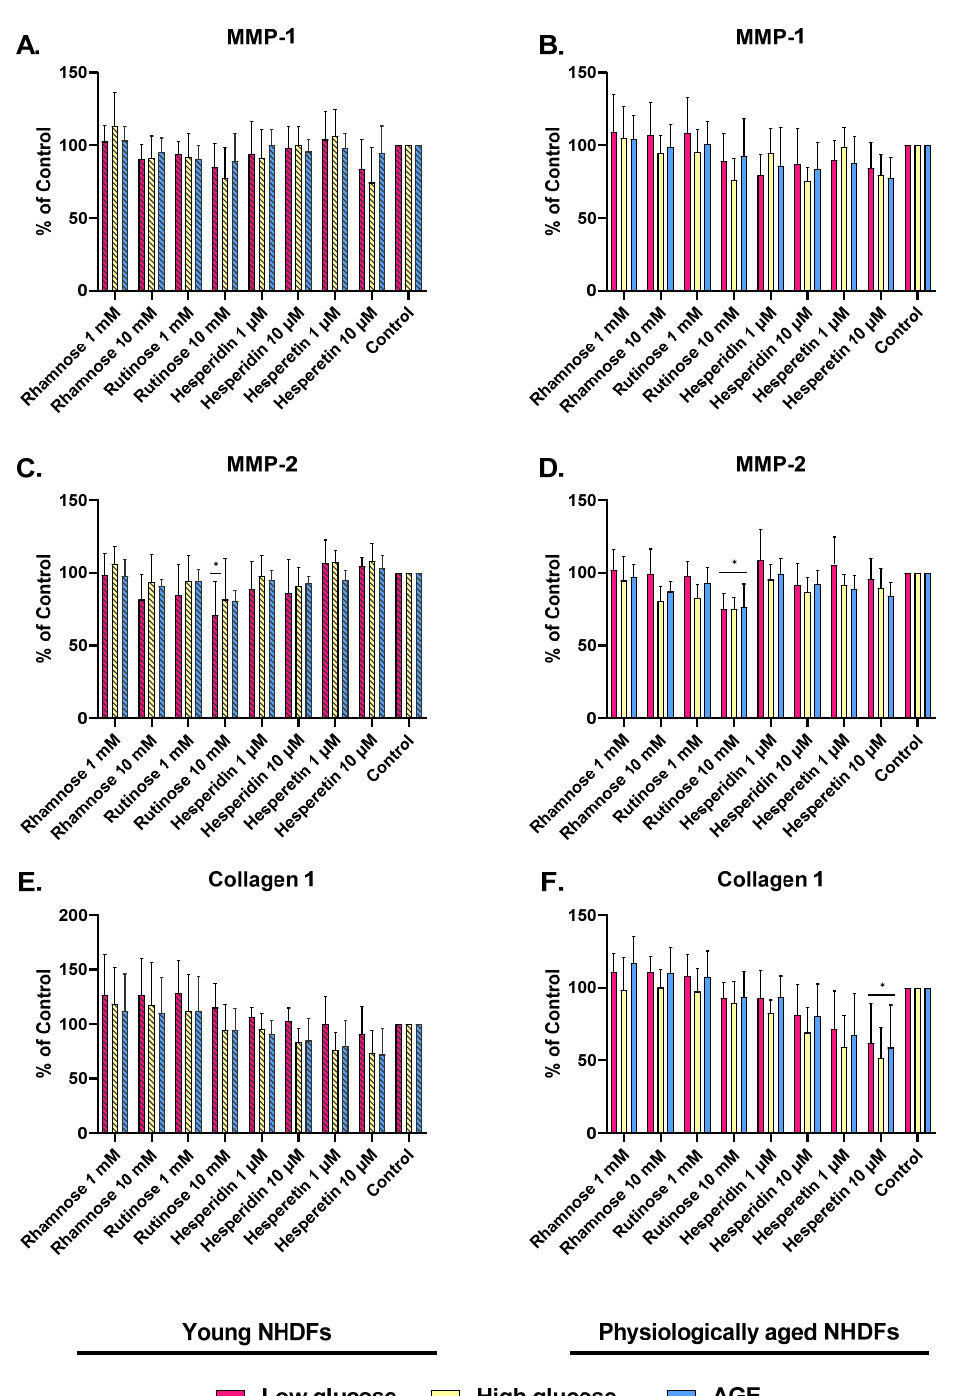
Figure 4. The effects of rhamnose, rutinose, hesperidin, and hesperetin on MMP-1, MMP-2, and collagen 1 production. MMP-1 ( A ), MMP-2 ( C ), and collagen 1 ( E ) production in young NHDFs, that were cultivated in low glucose medium or high glucose medium or medium supplemented with AGEs and the effects of rhamnose, rutinose, hesperidin, and hesperetin on MMP-1 ( B ), MMP-2 ( D ) and collagen 1 ( F ) production in physiologically aged NHDFs cultivated in low-glucose medium, high-glucose medium and medium supplemented with AGEs. Untreated NHDFs cultured in the respective media were used as controls. A number of measurements: n = 6. * p < 0.05 were considered significant compared to the control. (One-way ANOVA; Dunnett’s multiple comparisons tests were performed using GraphPad